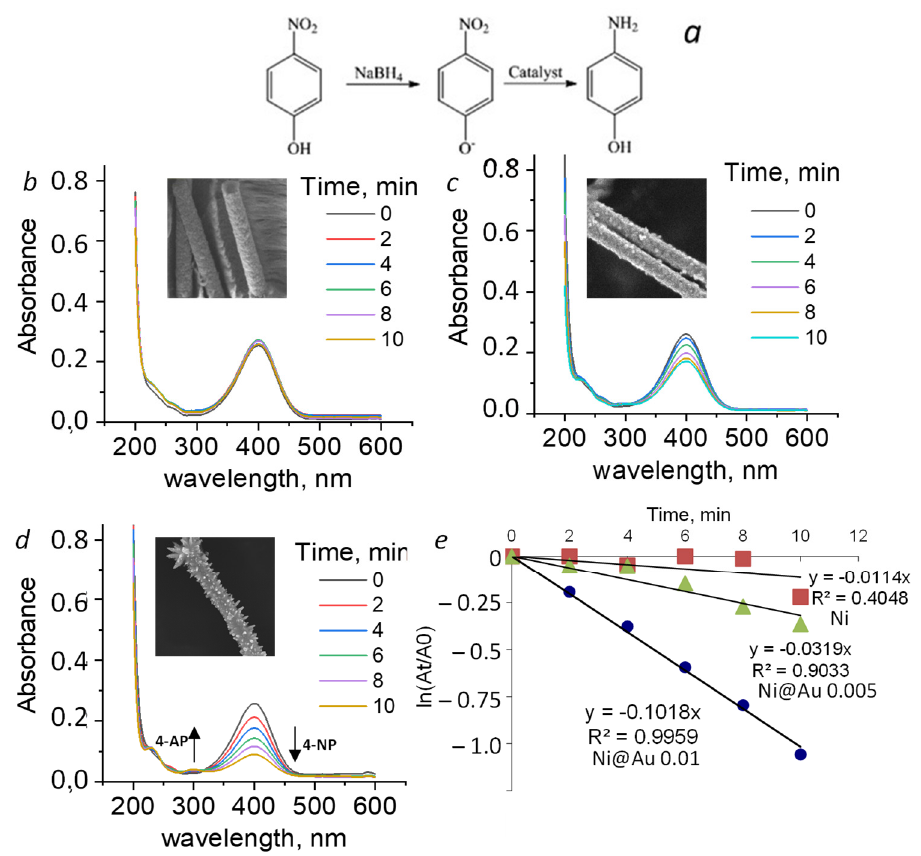
Figure 6. Catalytic reaction of the reduction of 4-nitrophenol by borohydride ions in an aqueous solution ( a ). UV-FTIR spectra of the reduction in the presence of Ni ( b ), Ni@Au 0.005 M ( c ), and Ni@Au 0.01 M ( d ). Kinetic analysis of the competitive reduction according to Equation (6) ( e ).